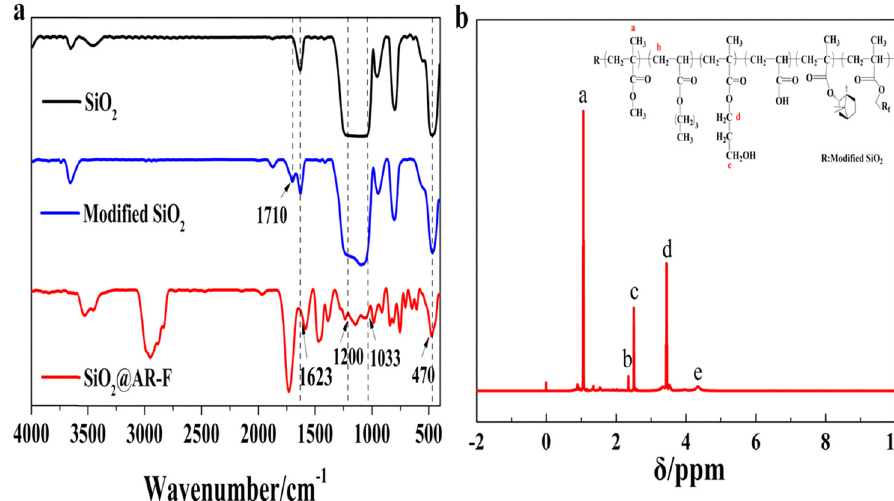
Figure 1: FTIR of SiO 2 , modi fi ed SiO 2 , and SiO 2 @AR - F ( a ) and 1 H - NMR of SiO 2 @AR - F ( b )